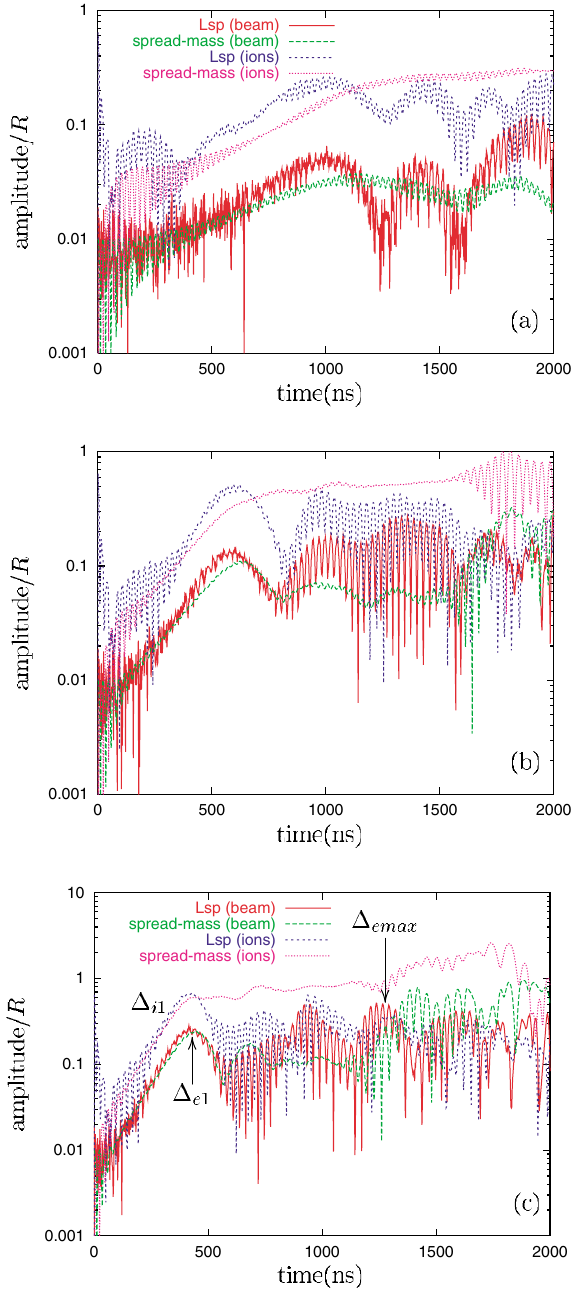
FIG. 6. (Color) Comparison of centroid displacements at the end of the drift space from LSP and spread-mass models. (a) ) and ions compares the first nonlinear peak for the beam ( " e 1 ). (b) shows the first ( " ) and maximum ( " ) peaks for , " , and ( " i 1 e 1 e max e 1 i 1 the beam.